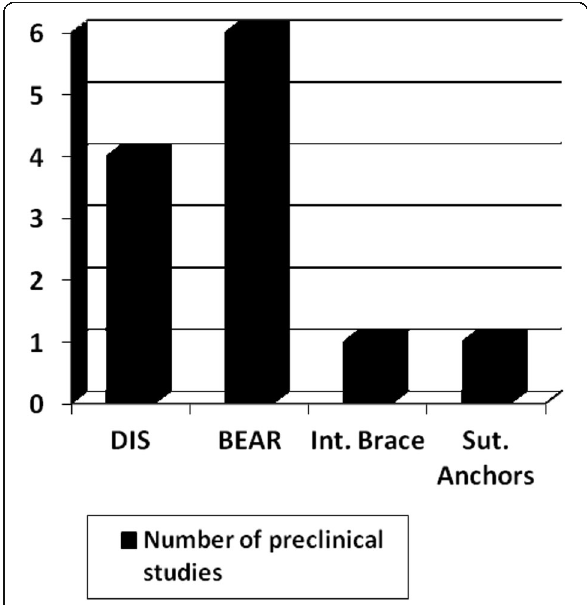
Fig. 2 Bar graph depicting the number of preclinical studies investigating the DIS technique, the BEAR, the ACL internal brace and the suture anchors ACL repair. DIS: dynamic intraligamentary stabilization, BEAR: bridge-enhanced ACL repair, Int. Brace: internal brace, Sut. Anchors: suture anchors, ACL: anterior cruciate